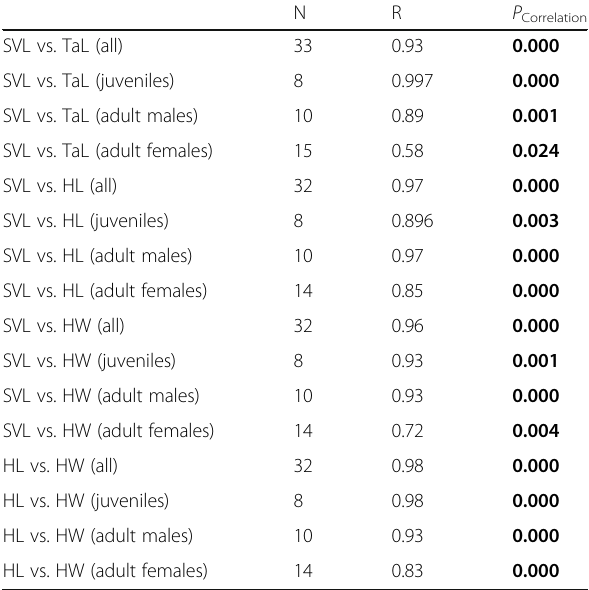
Table 3 Correlation coefficients (R) between morphometric characteristics of blunt-nosed vipers from Cyprus (significant P values